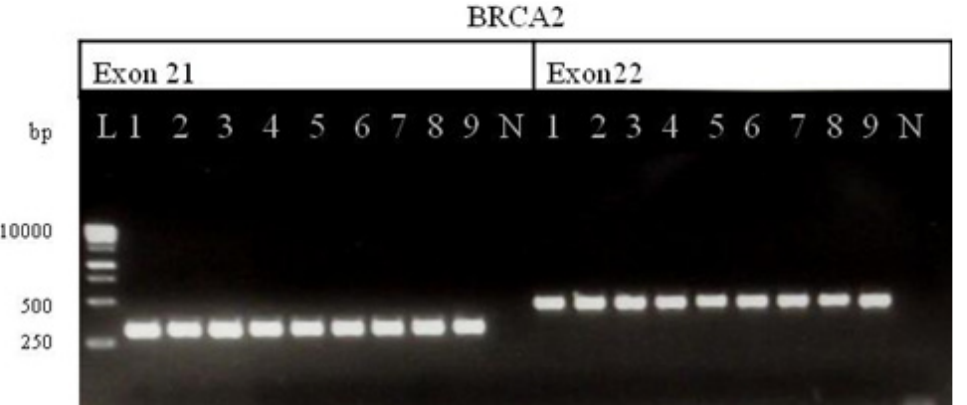
Figure 1: BRCA2 , Exon 21 and 22 PCR product profile in agar gel 2%. Legend: L: Fermentas GeneRulerTM DNA Ladder #SM0313; N: Negative control; Number 1 to 9: specimens.